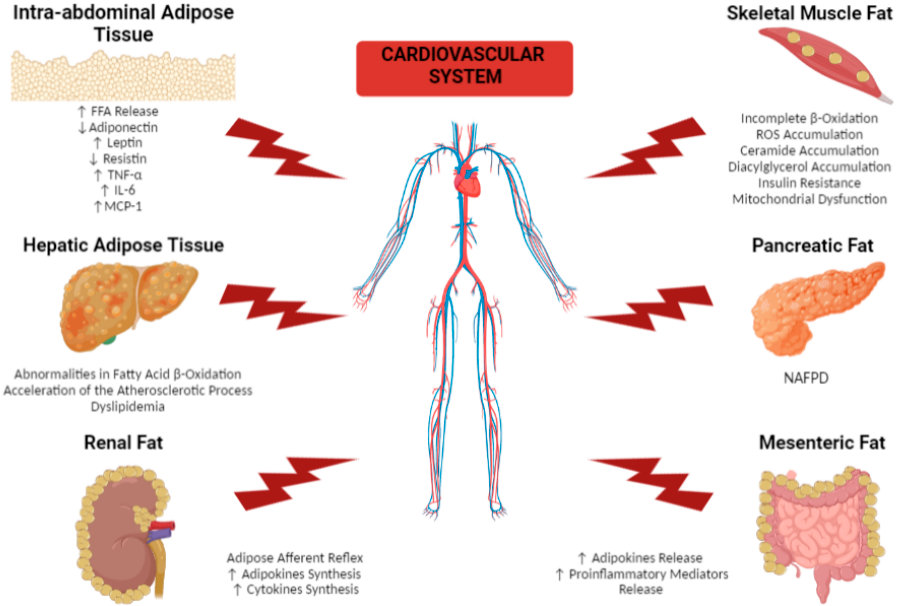
Figure 1. Molecular mechanisms mediating the harmful impact of remote adipose tissue depots on the cardiovascular system in obese patients. The figure illustrates the main molecular mechanisms by which remote fatty acid depots, including intra-abdominal tissue, hepatic adipose tissue, skeletal muscle fat, pancreatic fat, renal fat and mesenteric fat damage the cardiovascular system in obese patients through endocrine and paracrine mediators affecting the heart and the vasculature. FFA, free fatty acid; IL-6, interleukin-6; MCP-1, monocyte chemoattractant protein-1; NAFPD, nonalcoholic fatty pancreas disease; TNF- α , tumor necrosis factor- α ; ↑ increased; ↓ decreased.